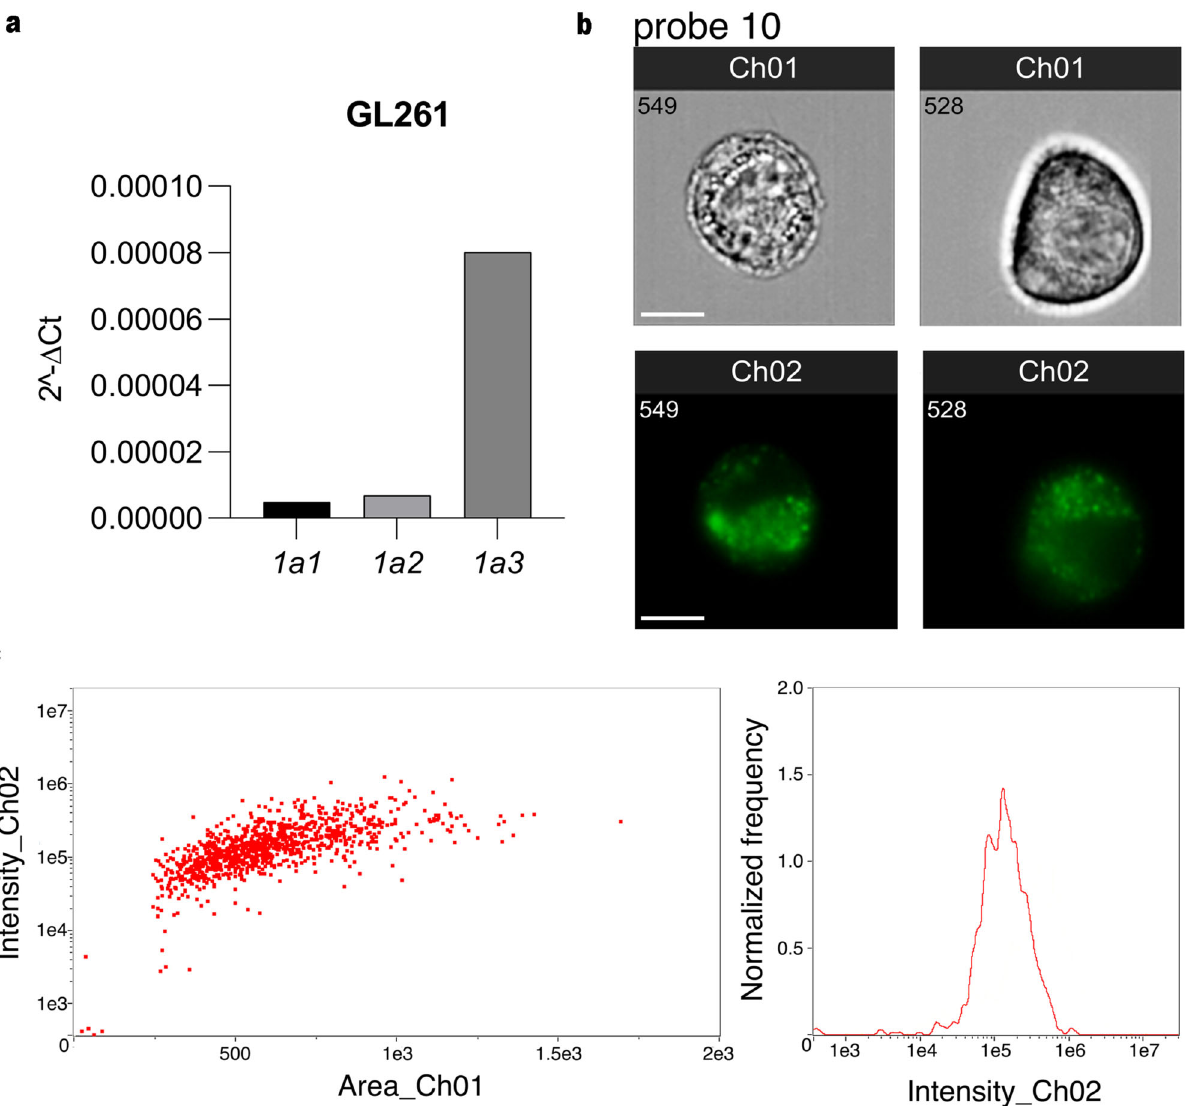
Fig. 7 In vitro experiments showing that ALDH1A3 is the most expressed isoform in GL261 murine glioma cells and both fl uorescent substrates enter and label the same cells. a Results of quantitative rtPCR showing the levels of expression of ALDH1A1 (1a1), ALDH1A2 (1a2) and ALDH1A3 (1a3) in murine GL261 cells. ALDH1A3 is signi fi cantly more expressed than the other isoforms. b Living GL261 cells were analyzed through an ImageStreamX MarkII using two channels: bright fi eld (Ch 01) and fl uorescence (Ch 02) after 1 h incubation in probe 10, cells were thoroughly washed in PBS and analyzed. Two different representative cells are shown. From above, row 1 bright fi eld images (Ch 01), row 2 fl uorescent images (Ch 02). “ In Focus Cells ” were identi fi ed based on the “ Gradient Root Mean Square (RMS) Contrast Feature ” that captures in focus images of cells identi fi ed by high normalized pixel intensity gradient (RMS values) derived from Ch 01; then, a scatter plot of the “ Aspect Ratio Feature ” vs. bright fi eld “ Area Feature ” was used to identify single cells (singlets) from debris or cell clumps based on high aspect ratio and low area value. c Fluorescence intensity variations are shown in the histogram and dot plot (Area vs. Intensity). Scale bars: 5 µ m are the same in all